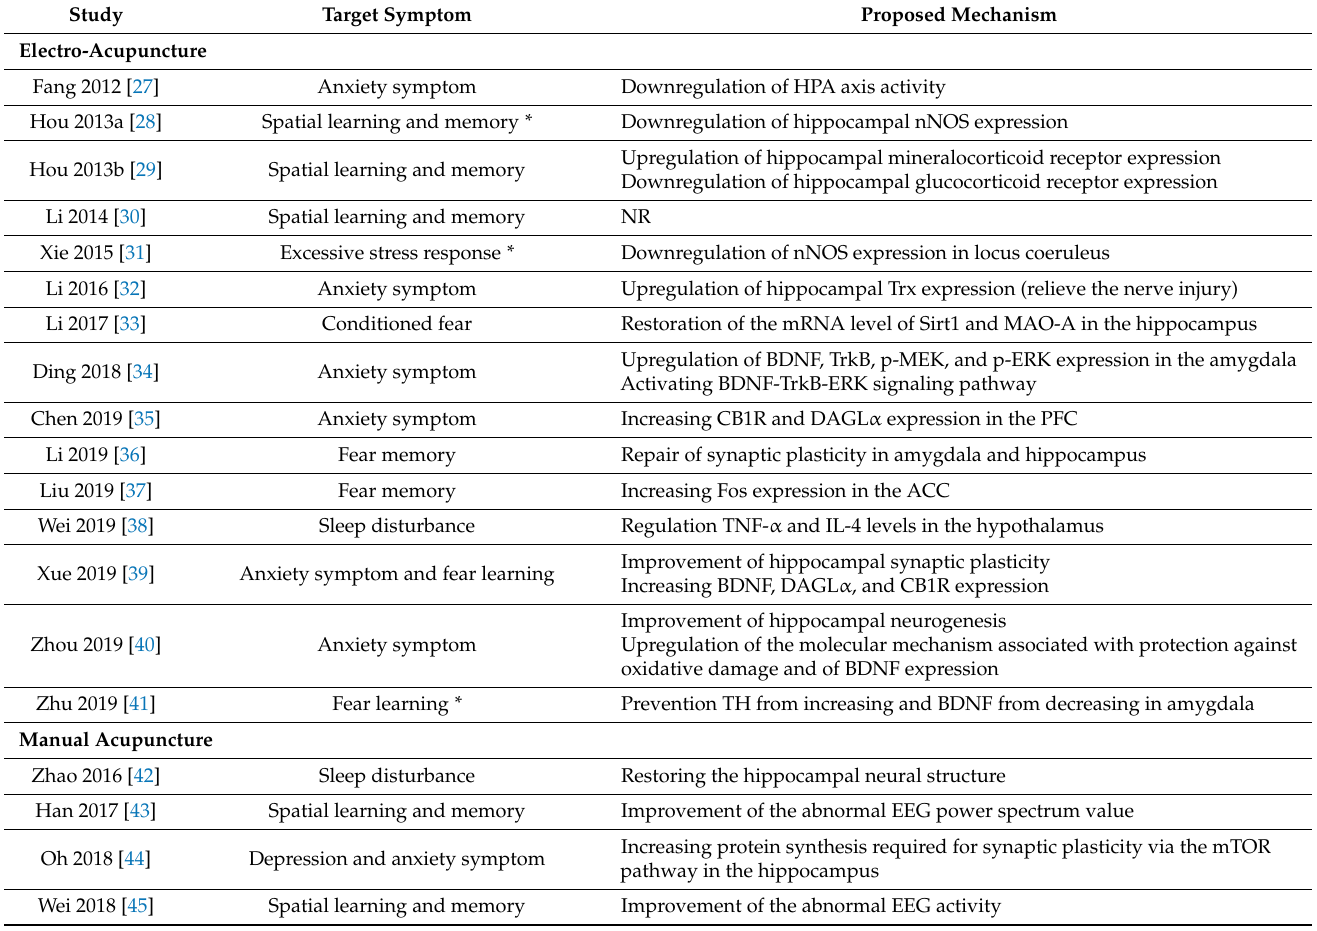
Table 2. Target symptoms and proposed